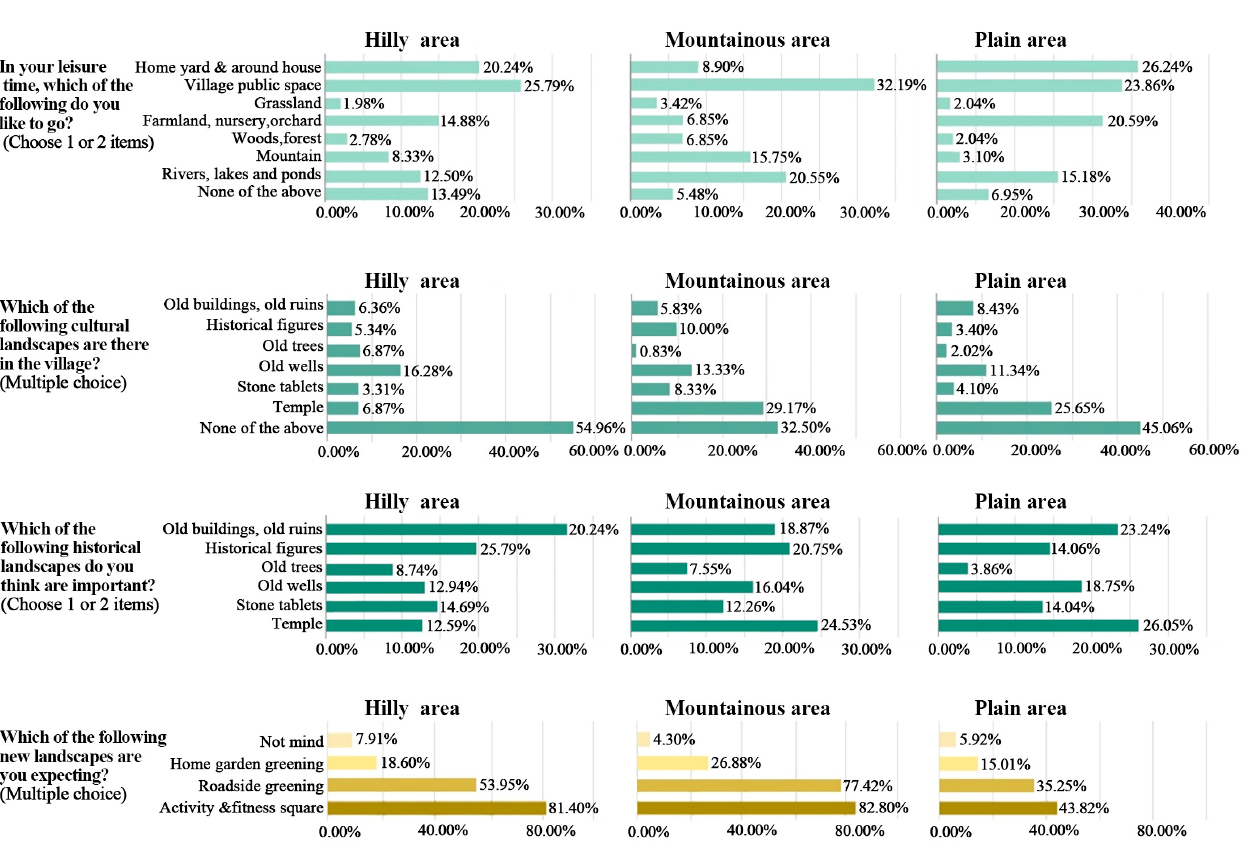
Figure 2. Cultural Service Preference Statistics Chart.